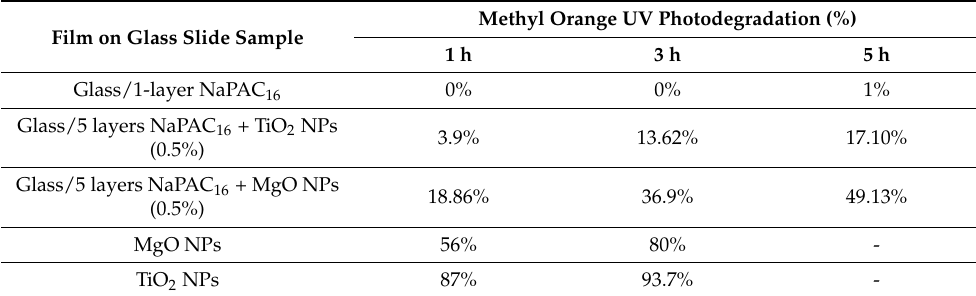
Table 7. Photodegradation efficiency of MO measured on the two types of composite